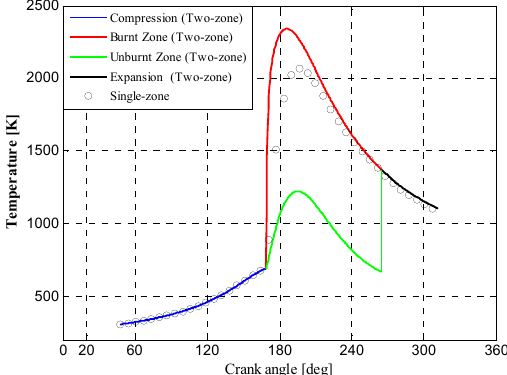
Figure 8. In-cylinder temperature in two-zone models and single-zone models.